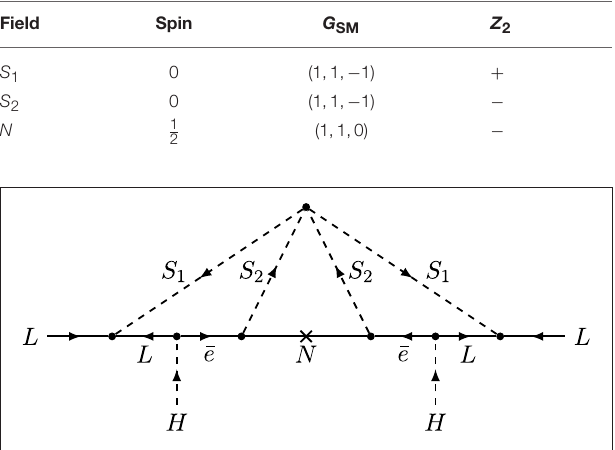
TABLE 8 | Quantum numbers for new particles in the original KNT model.